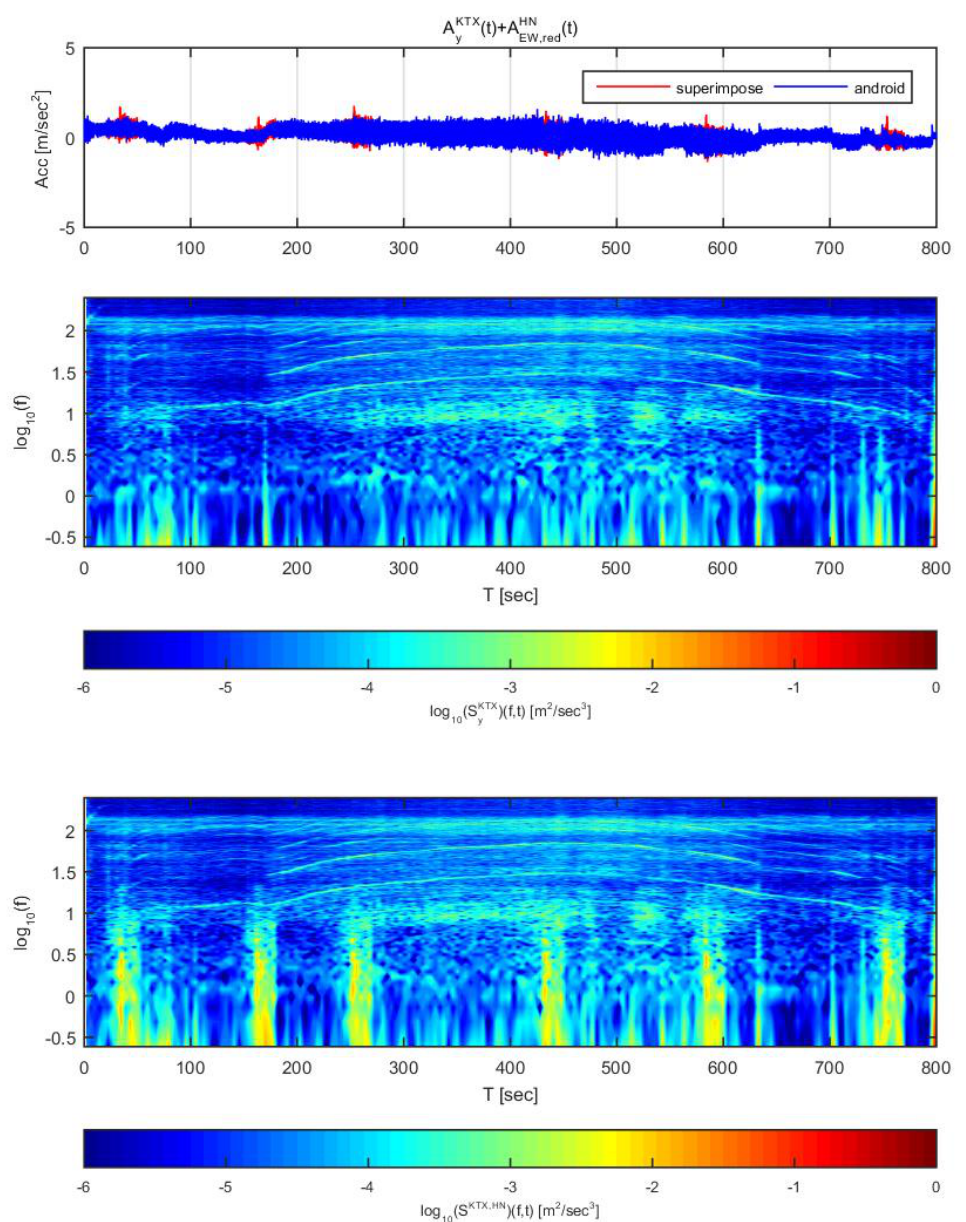
Figure 18. Combination of Korea Train Express (KTX) transverse direction data and Hachinohe east-west direction data (adjusted to 1 m / s 2 ).